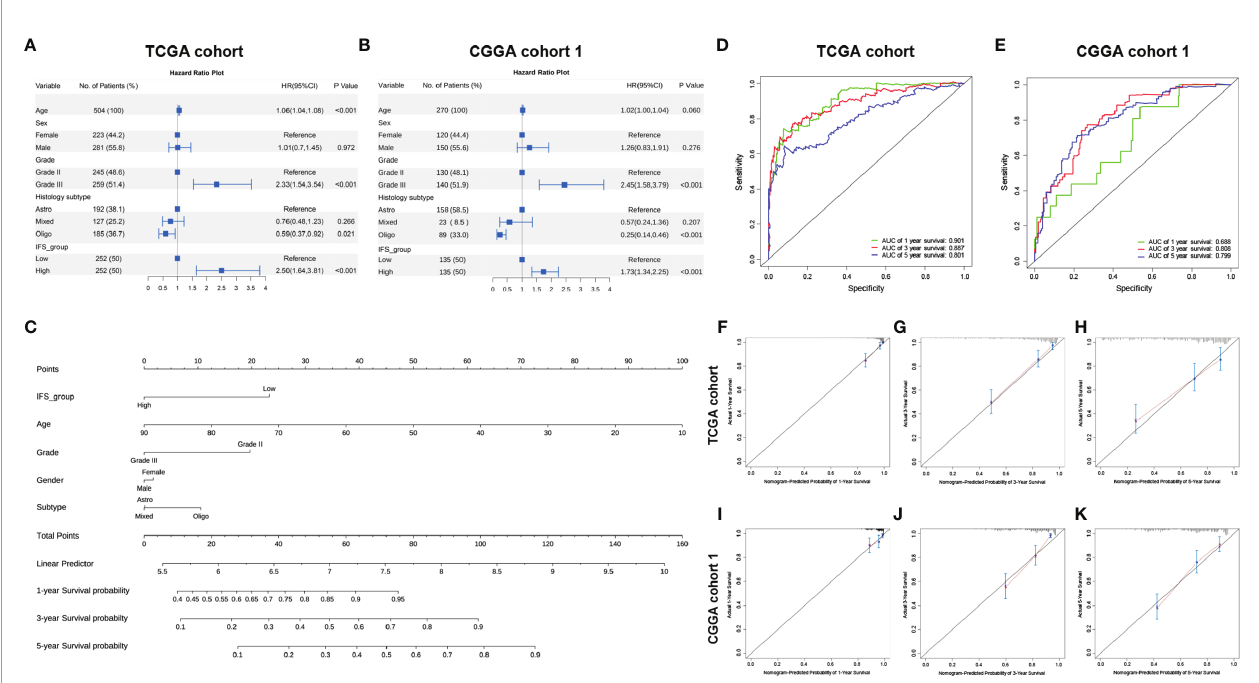
FIGURE 4 | The in fl ammatory signature was a strong independent prognostic factor for LGG patients in the TCGA cohort and CGGA cohort 1. Forest plot of multivariate regression analysis in the TCGA cohort (A) and CGGA cohort 1 (B) . Nomogram based on the results of multivariate cox regression analysis in the TCGA cohort (C) . The ROC curve and AUC of the predictions for 1, 3, and 5 years of the nomogram for the TCGA cohort (D) and CGGA cohort 1 (E) . The calibration curves for predicting the 1-, 3-, and 5-year survival in the TCGA cohort (F – H) and CGGA cohort 1 (I – K)